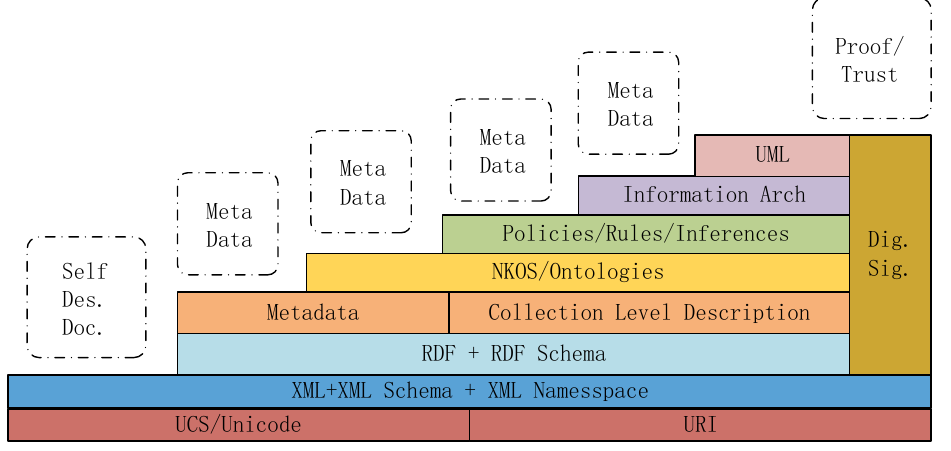
Figure 1. The architecture of the semantic